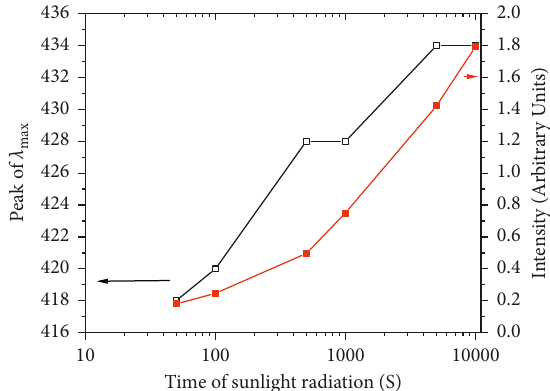
Figure 2: Effect of sunlight radiation on the maximum wavelength ( λ max ) and absorbance of Ag NPs determined by UV-Vis spectrum. Reaction conditions were adjusted to 0.5g of U. maydis , at pH 10 and room